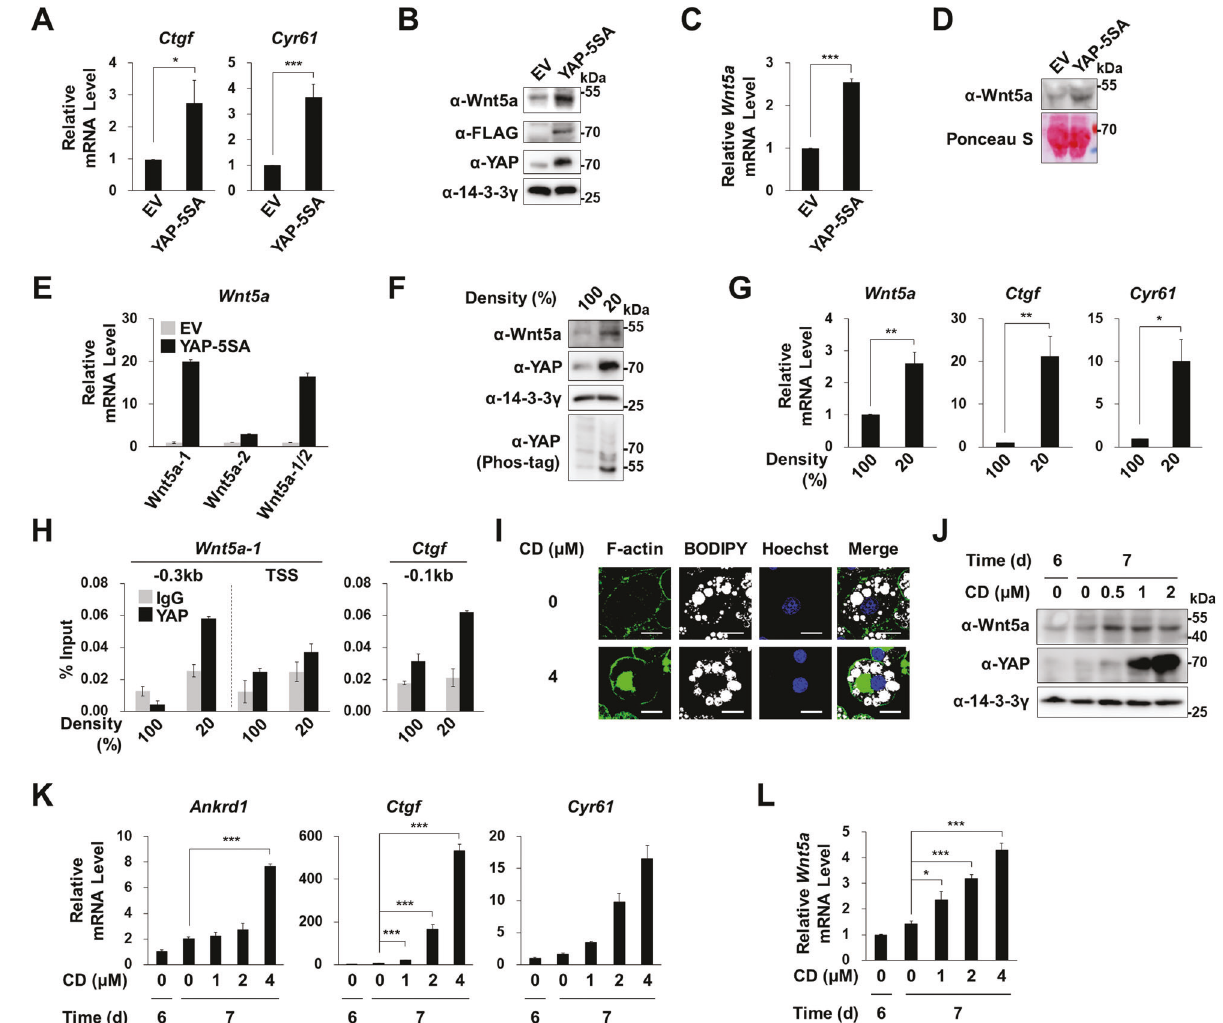
Fig. 4 YAP activation and Wnt5a expression. A – E 3T3-L1 cells were infected with a retrovirus encoding FLAG-tagged YAP-5SA (YAP-5SA) or empty vector (EV). A qRT-PCR analyses of Ctgf and Cyr61 mRNA levels, which were normalized versus 18 S rRNA levels. B Western blot analyses using antibodies against Wnt5a, FLAG, YAP, and 14-3-3 γ . C qRT-PCR analyses of Wnt5a mRNA levels, which were normalized versus 18 S rRNA levels ( D ) Western blot analyses of Wnt5a in conditioned media (CM) harvested from EV- or YAP-5SA-infected 3T3-L1 cells cultivated for 2